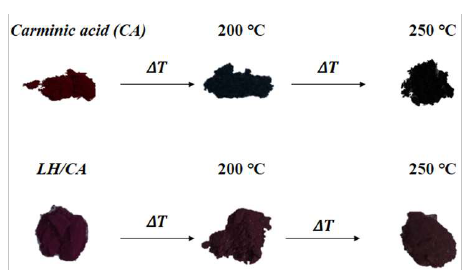
Figure 9. Color changes of carminic acid and LH/CA (20%).